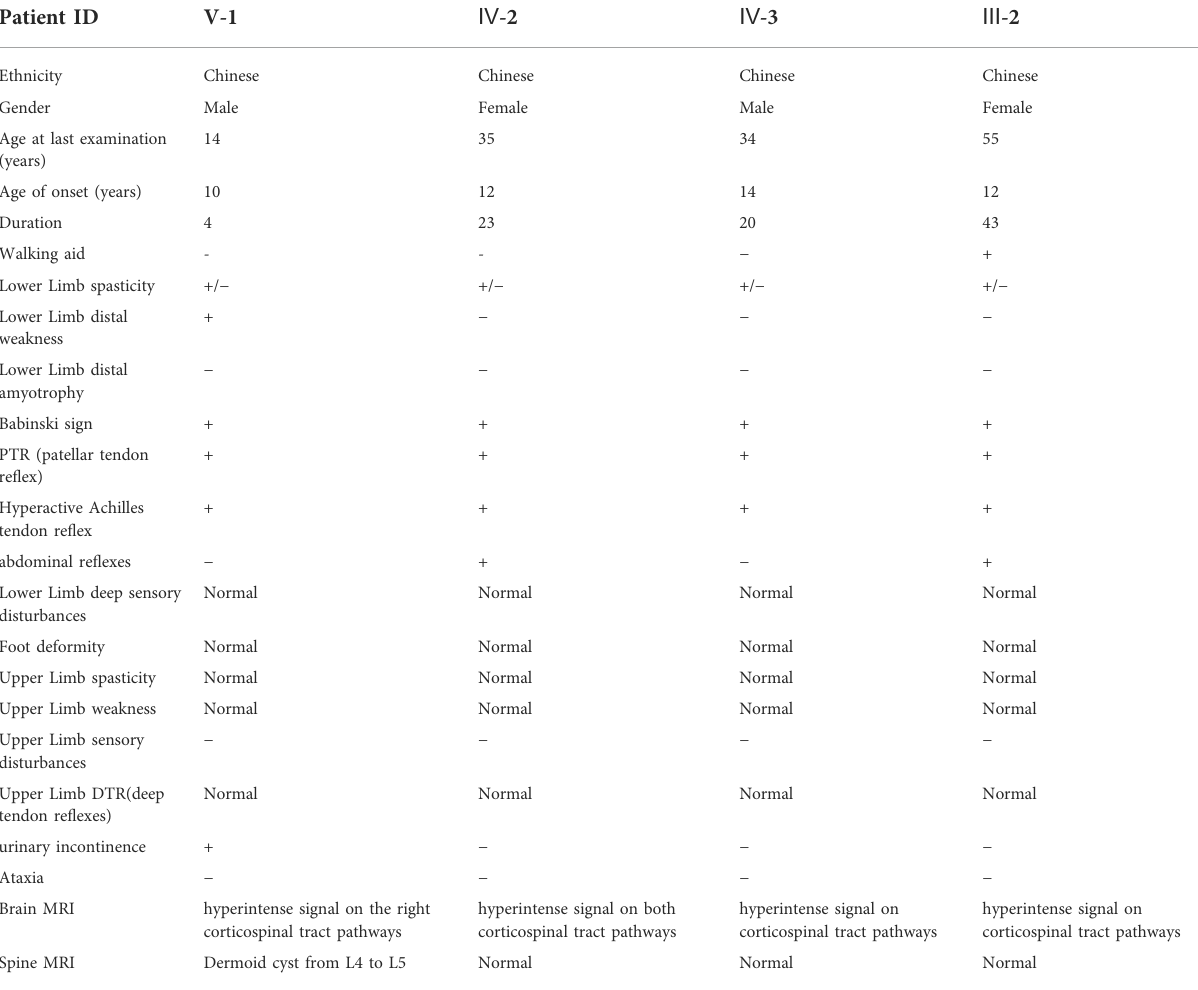
TABLE 1 Detailed clinical information of affected individuals in HSP patients of this